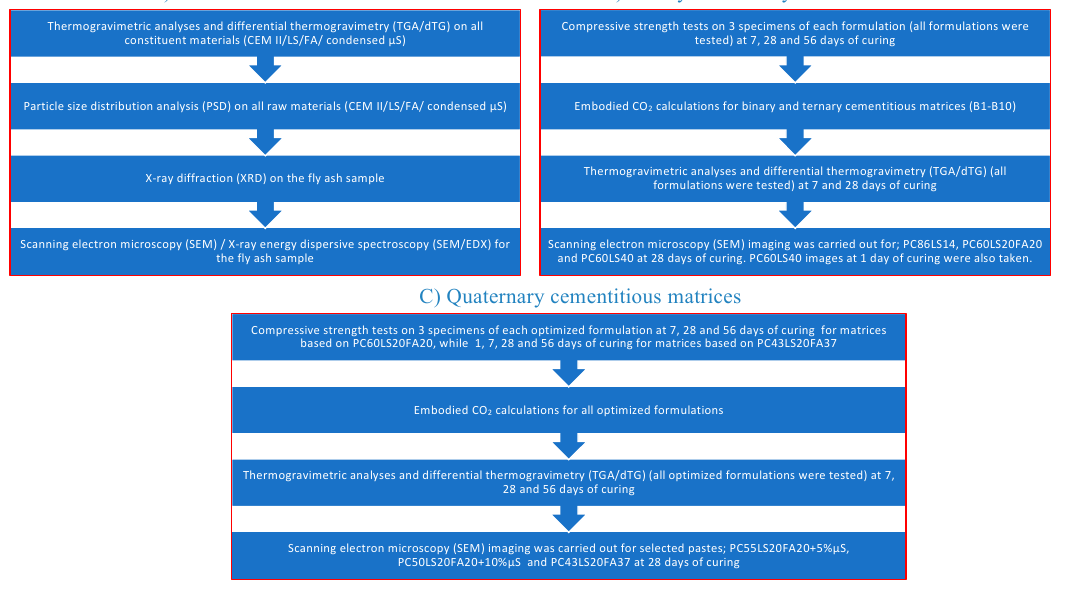
Figure 3. Overview of the experimental program.